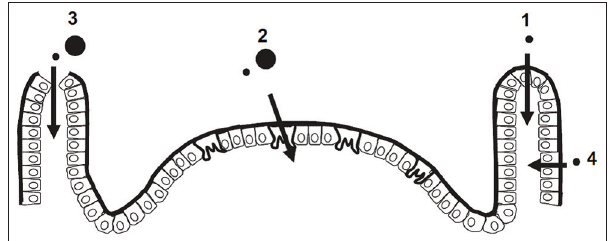
Figure-1: Transcellular route, at the apex of the intestinal epithelium (pinocytosis): (1) Endocytosis. (2) M-cell uptake (transcytosis). (3) Persorption. (4) Putative paracellular uptake